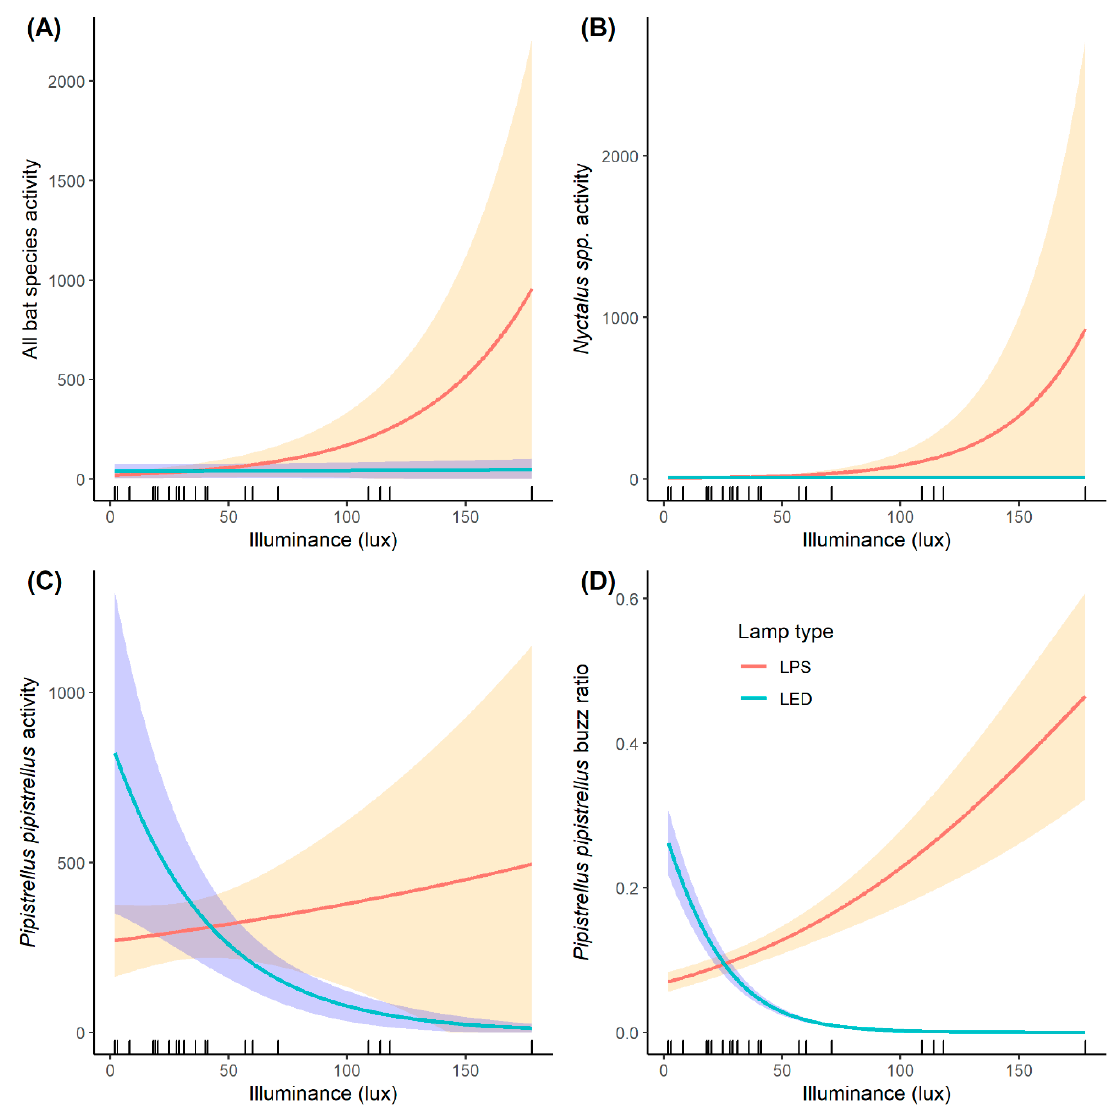
Figure 3. Predicted bat activity (total bat activity could ( A ), Nyctalus spp . Activity ( B ), Pipistrellus pipistrellus activity ( C ) and P. pistrellus buzz ratio ( D ) as a function of the light illuminance according to the lamp type (light emitting diodes (LED) and low pressure sodium (LPS)). Results come from interactions presented in the light illuminance modeling (left side of Table 2). Table 2. Effects of the type of lamp (LPS versus LED), the lamp intensity (illuminance or power), and their interaction on bat activity. The estimates of LampLPS are the difference in bat activity between LPS lights and LED lights placed as intercept (i.e., a negative estimate indicates that bat activity is lower with LPS compared to LED for a given light intensity). The estimates of the interaction ( LampLPS:Lamp intensity ) correspond to the difference of slope between the two regressions (bat activity ~ Lamp intensity) according to the lamp type (i.e., LPS versus LED).